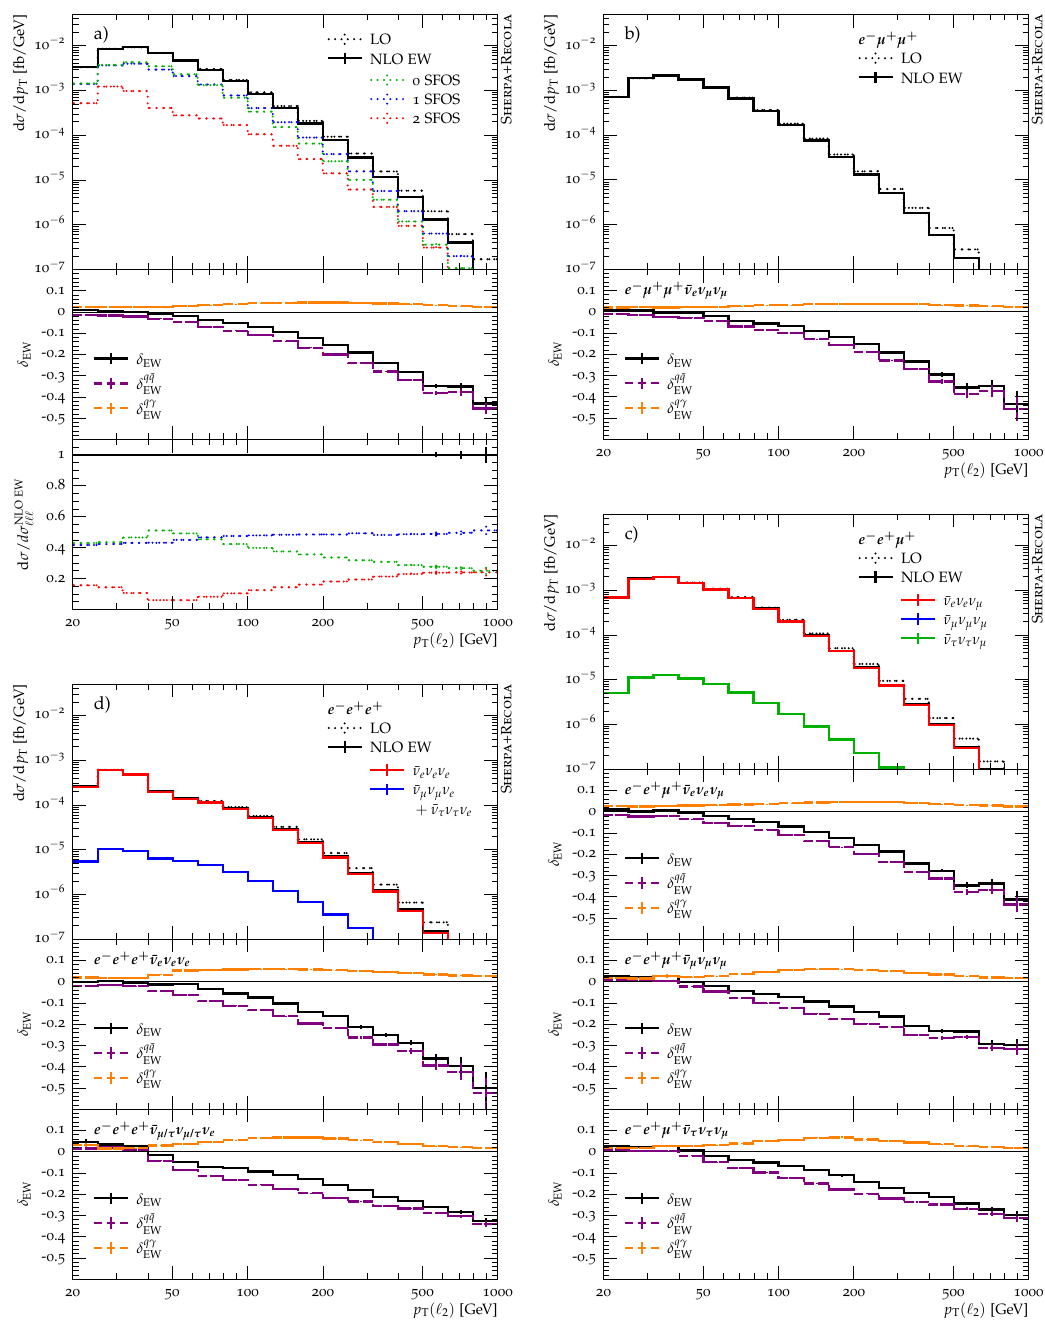
Figure 4 . Electroweak corrections to the subleading lepton transverse momentum